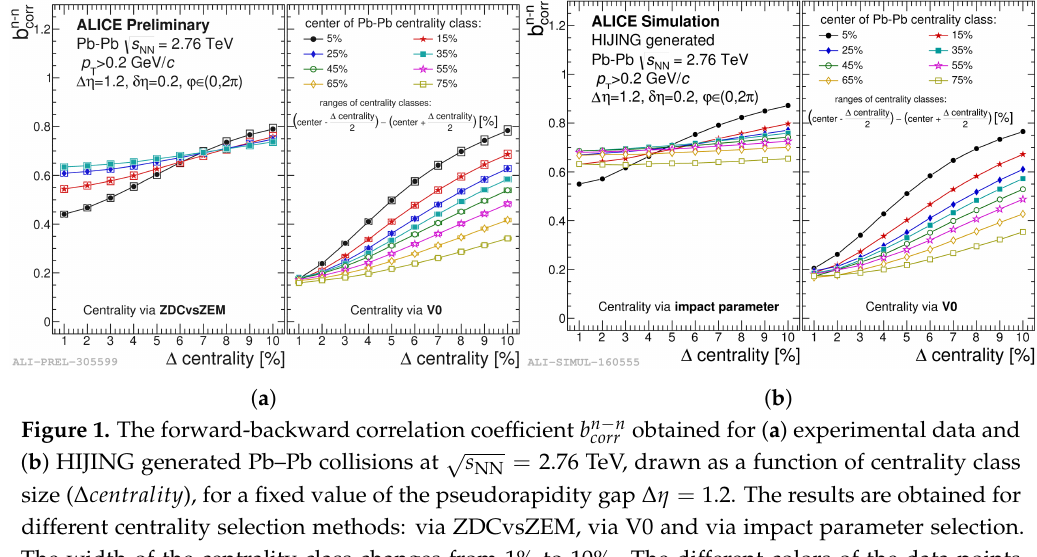
Figure 1. The forward-backward correlation coefficient b n − n corr obtained for ( a ) experimental data and √ s NN = 2.76 TeV, drawn as a function of centrality class ( b ) HIJING generated Pb–Pb collisions at size ( ∆ centrality ), for a fixed value of the pseudorapidity gap ∆ η = 1.2. The results are obtained for different centrality selection methods: via ZDCvsZEM, via V0 and via impact parameter selection. The width of the centrality class changes from 1% to 10%. The different colors of the data points correspond to different centralities of the Pb–Pb collision. Systematic uncertainties are shown as rectangles, statistical uncertainties are smaller than marker